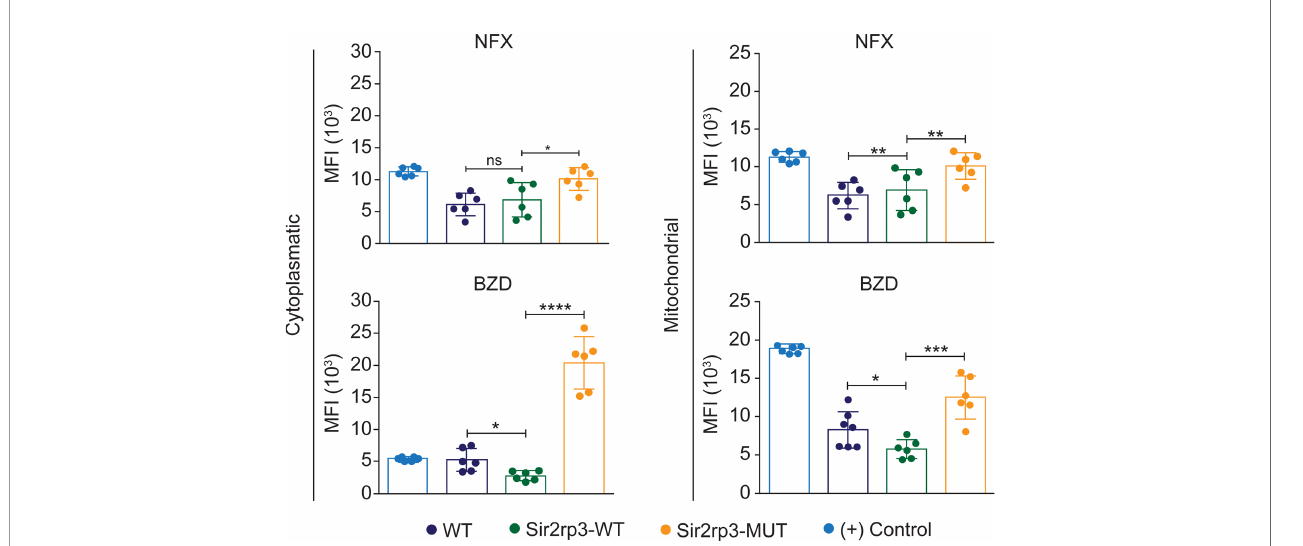
FIGURE 3 | Mitochondrial sirtuin decreases ROS levels after BZD and NFX treatment. Sir2rp3-WT epimastigote presented lower cytosolic and mitochondrial ROS levels after BZD and NFX treatment compared with WT and Sir2rp3-MUT parasites. A signi fi cant increase of ROS levels was observed in Sir2rp3-MUT. WT parasites